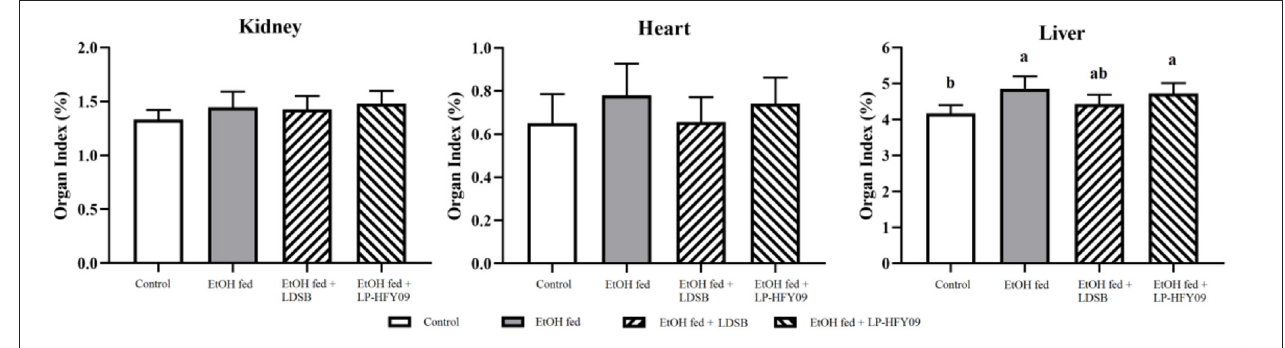
FIGURE 2 | Organ indexes of mice in each group ( n = 10). a,b In the same sheet means significant differences ( p < 0.05). Control, mice without treatment; EtOH fed, mice treated with 56 ◦ ethanol of 0.13 ml/10g bw; EtOH fed + LDSB, mice treated with 1.0 × 10 9 CFU/kg of Lactobacillus delbruechill subsp. bulgaricus before ethanol-treatment; EtOH fed + LP-HFY09, mice treated with 1.0 × 10 9 CFU/kg of Lactobacillus plantarum HFY09 before ethanol-treatment.